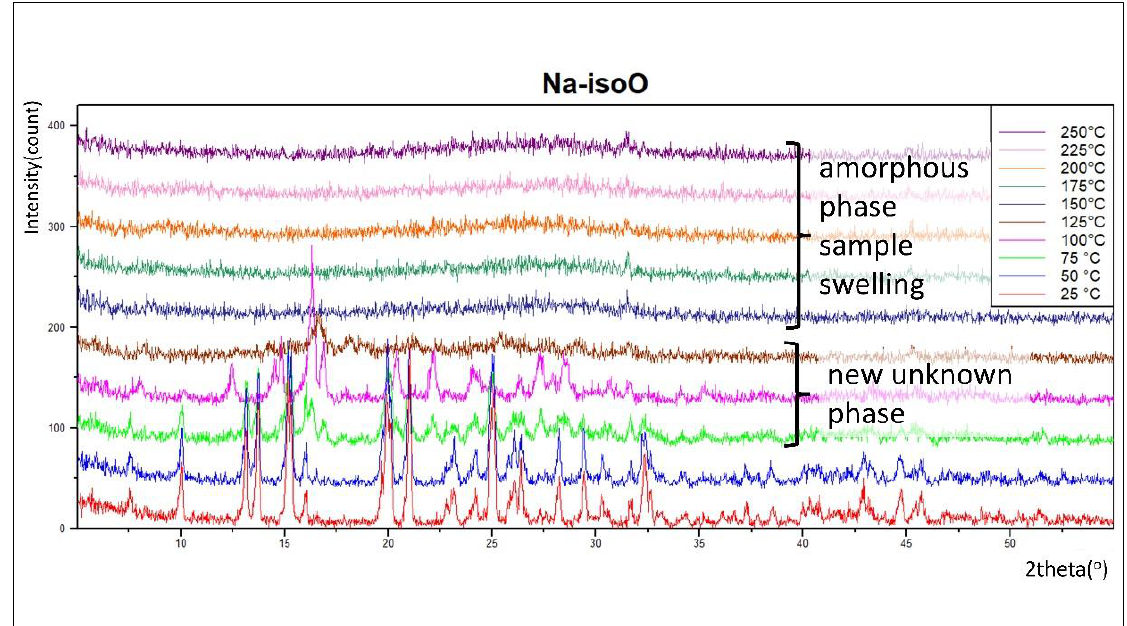
Figure 5. XRPD vs. temperature: thermal decomposition studies of the compound Na-isoO (see text for description). The estimated from Scherrer equation size of crystallites (at 25 °C) was about ~65 nm (see Table S3 for details).